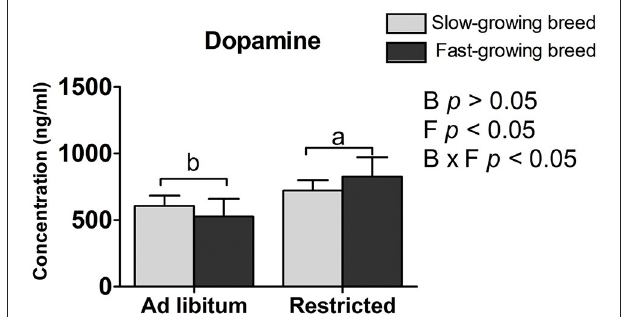
FIGURE 3 | GO terms of differentially expressed genes (DEGs) between SA and FA groups. SA, slow-growing dual-purpose chickens ad libitum ; FA, fast-growing broilers ad libitum .